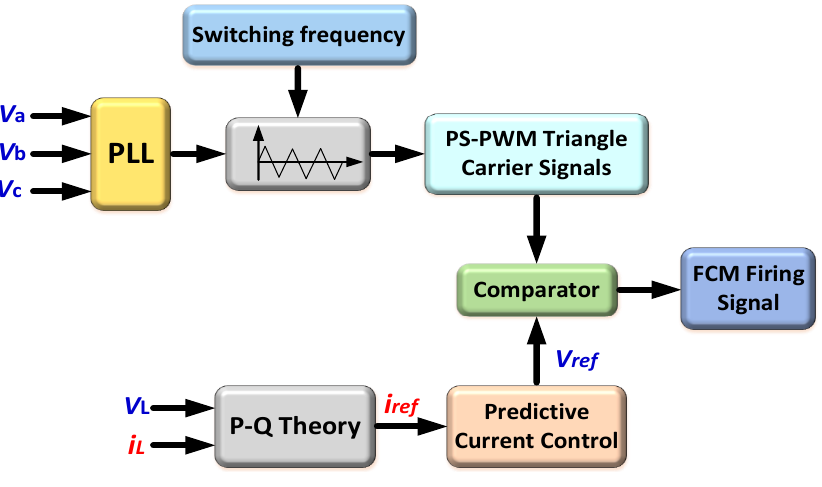
Figure 16. Predictive current control [142].